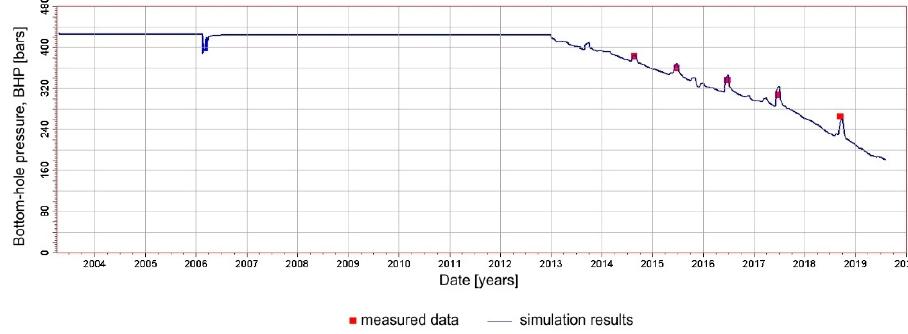
Figure 10. Total reservoir gas production.